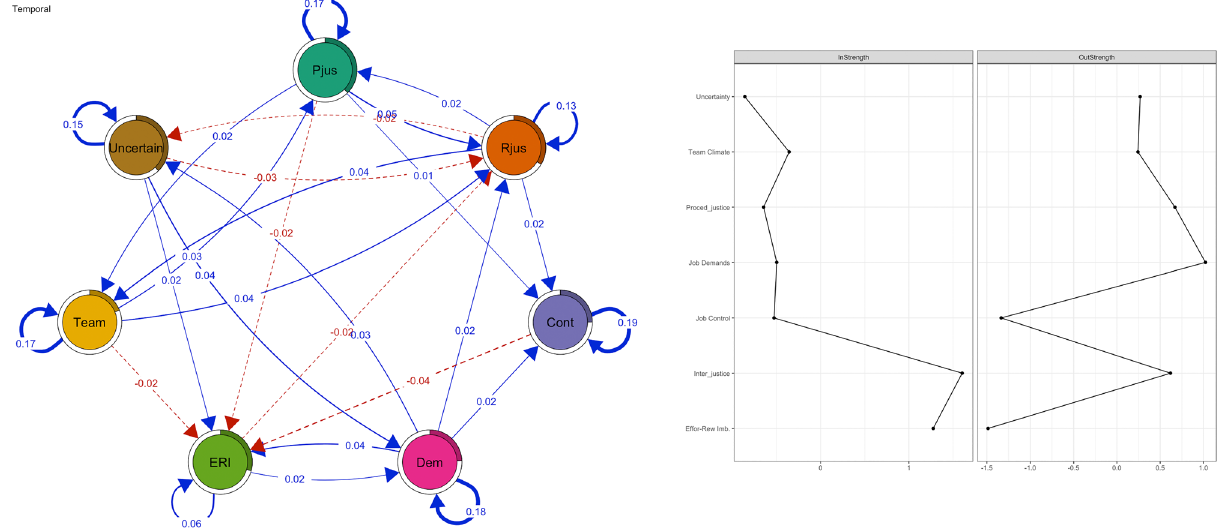
Figure 5. The temporal network between psychosocial factors (procedural justice = pjus, interactional justice = rjus, effort-reward imbalance = eri, job demands = dem, job control = cont, uncertainty = uncer, team climate =